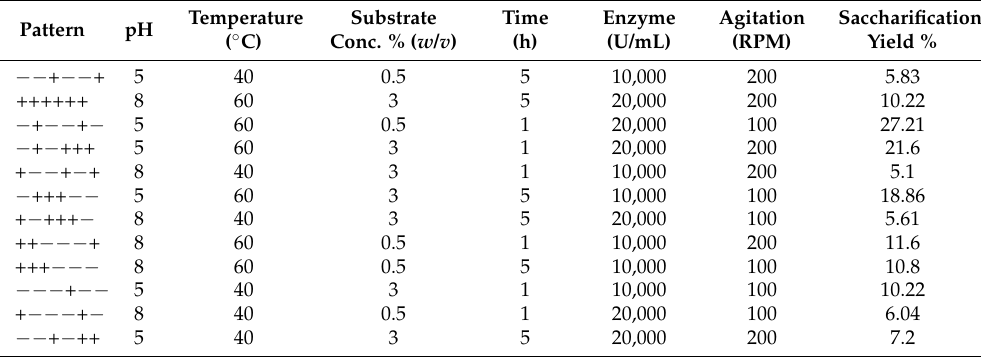
Table 11. Randomized Plakett–Burman experimental design for evaluating factors influencing saccharification yield percentage of chicory root by the inulinase enzyme produced from Rhizopus oryzae NRRL 3563.